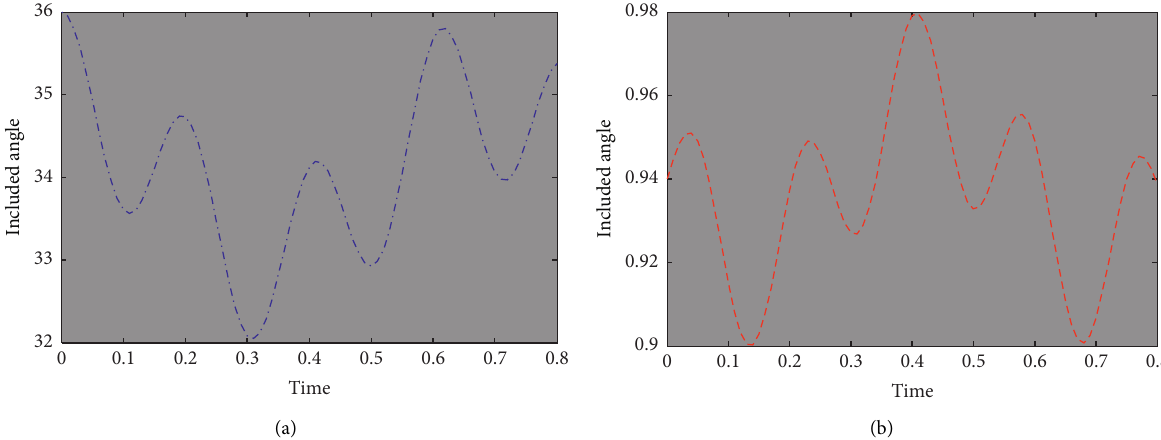
Figure 6: Initial attitude angle data: (a) the angle between the X axis and the horizontal position; (b) the angle between the Z axis and the horizontal position.